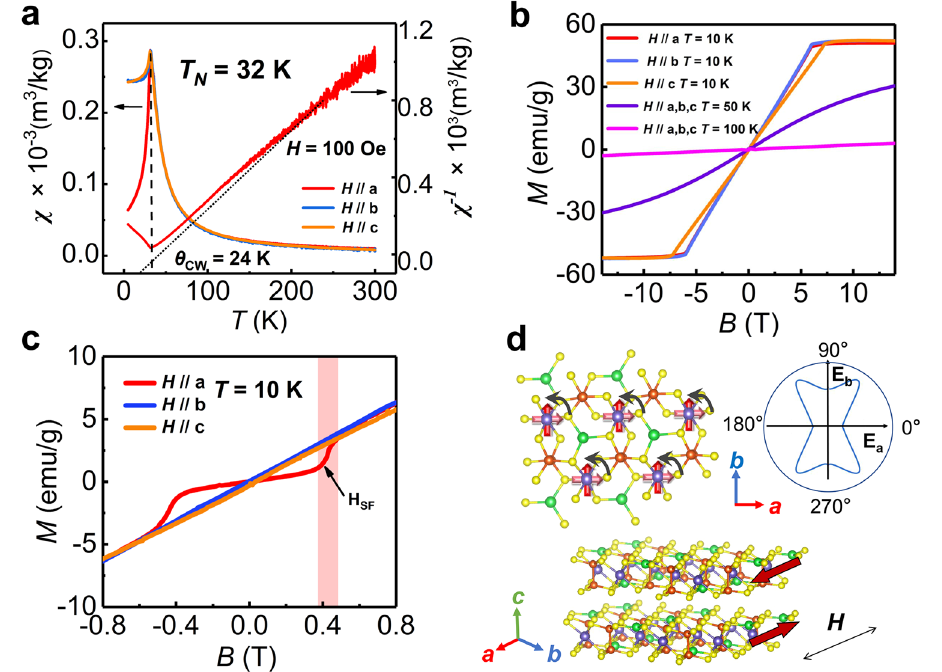
Fig. 3 | Magnetic properties of CCPS indicating the magnetic anisotropy and the spin- fl op (SF) transition. a Temperature dependence of magnetic suscept- ibility ( χ – T ) along the a , b , and c axes. The dotted line corresponding to the right axis is Curie-Weiss fi tting. b Magnetic fi eld dependence of magnetization ( M – H )